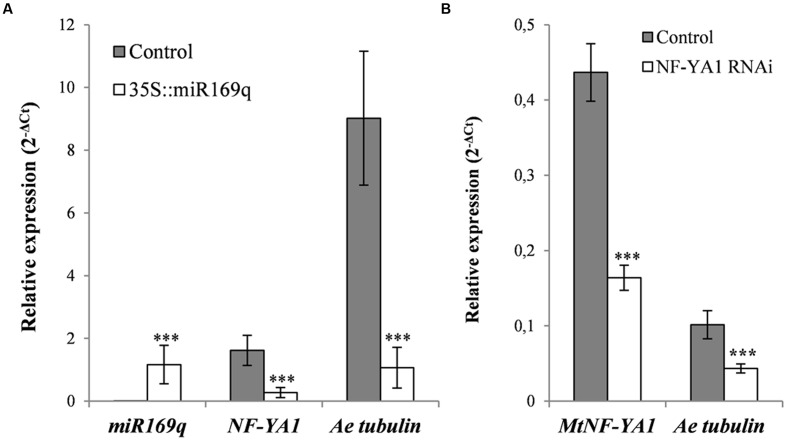
Silencing approaches of MtNF-YA1 in F83005.5 susceptible line. The pre-miR169q, MtNF-YA1 and A. euteiches tubulin transcripts were quantified by RT-qPCR and normalized with 2-ΔCT methods. (A) Overexpression of pre-miR169q reduces MtNF-YA1 transcripts accumulation 6 dpi and decrease A. euteiches development. Experiments were performed on three independent root organ culturelines for both control vector and pre-miR169q overexpressor. Expression values were standardized with the plant housekeeping gene Medtr4g097170. (B) Silencing of MtNF-YA1 by the overexpressing construct of antisense MtNF-YA1 3′UTR decreases A. euteiches development. Experiments were performed with 12 independent samples containing each 10 composites plants for both control and silencing vector. Expression were standardized with the mean of two reference genes Medtr4g097170 and Medtr6g021800. Wilcoxon rank sum test was applied for root organ culturesqRT-PCR results (∗∗∗p-value <0.001) and ANOVA was applied for composite plants qRT-PCR results (∗∗∗p-value <0.001).